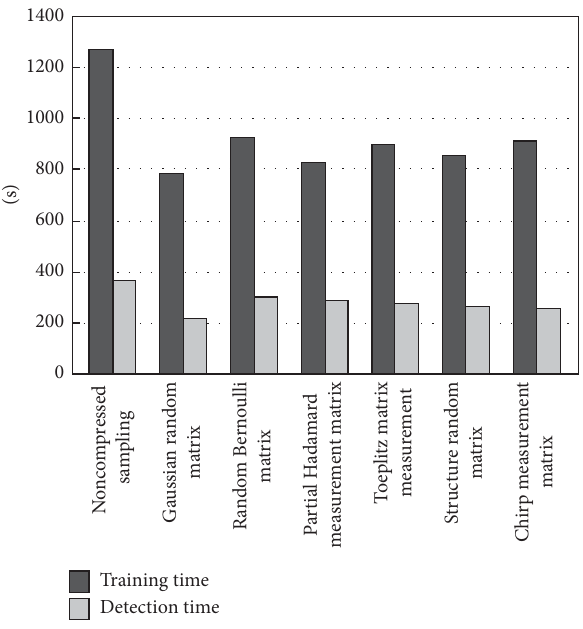
Figure 2: Training and detection time.